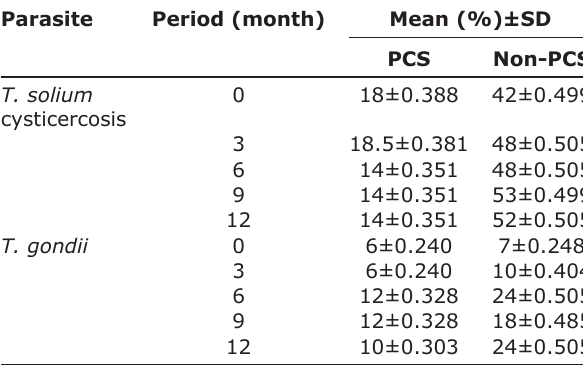
Table-2: Seroprevalence of parasite infections in confinement and non-confinement pigs.